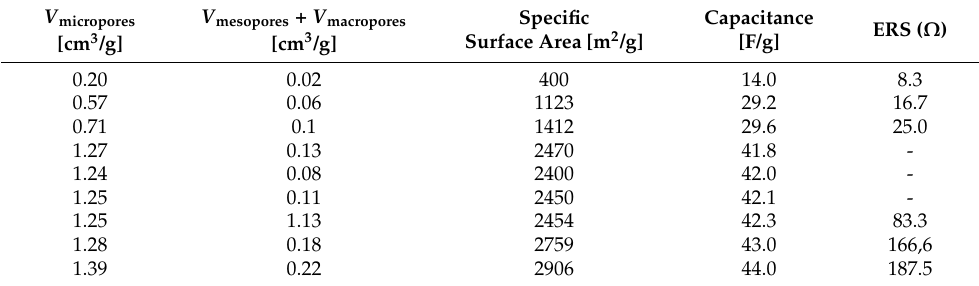
Table 2. Electric double-layer capacitors (EDLCs) capacitance dependence on electrodes porous texture [66].